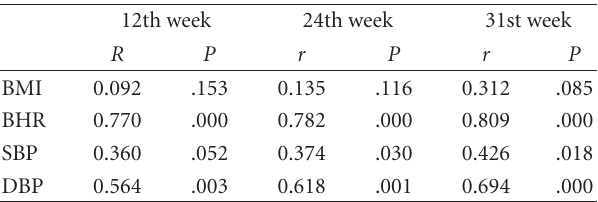
Table 5: Correlation of LF-HF ratio with body mass index (BMI), basal heart rate (HR), systolic blood pressure (SBP), and diastolic blood pressure (DBP) of subjects of early-onset PIH group at di ff erent weeks of